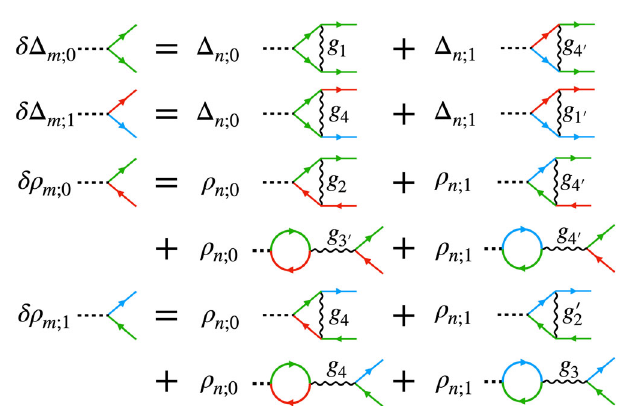
Fig. 3 | The 1 loop Feynman diagrams contributing to the SC and CDW vertex corrections. TheVHSindexstructureisshown(greenforv=0,red/blueforv=±1, respectively). SDW Diagrams for SDW vertex corrections are the same as the CDW diagrams with M insteadof ρ ,except for the loopdiagrams inthesecond lines that vanish for SDW vertices. The propagators additionally carry the magnetic fl avor indices,notshowninthe fi gure(thesecanbefoundintheSupplementaryMaterial).